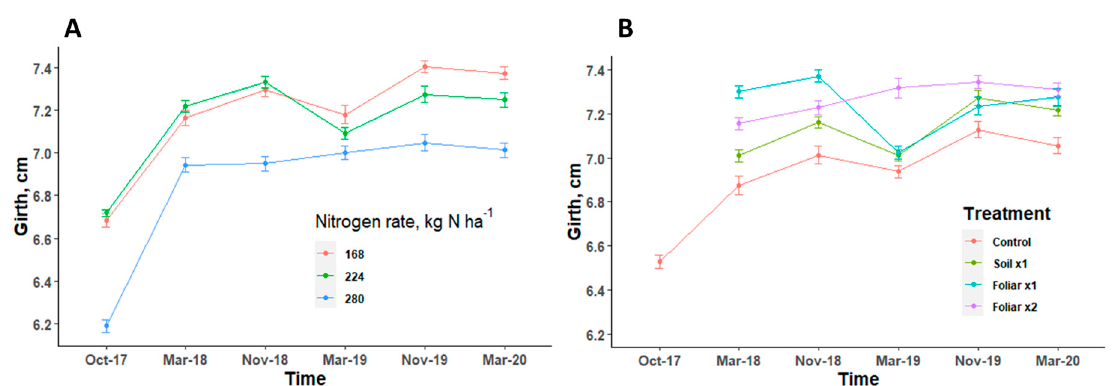
Figure 5. Trunk diameter of HLB-affected trees treated with different levels of nitrogen ( A ) [n = 12] and Zn ( B ) [n = 9] with standard error bars. Treatments: control—standard soil Zn applied; foliar x1—standard soil Zn applied + foliar-applied Zn based at 1× UF/IFAS recommendations; foliar x2—2× foliar-applied Zn at UF/IFAS recommendations + standard soil Zn application; soil x1—2× soil-applied UF/IFAS recommendations (5.60 kg Zn ha − 1 ).